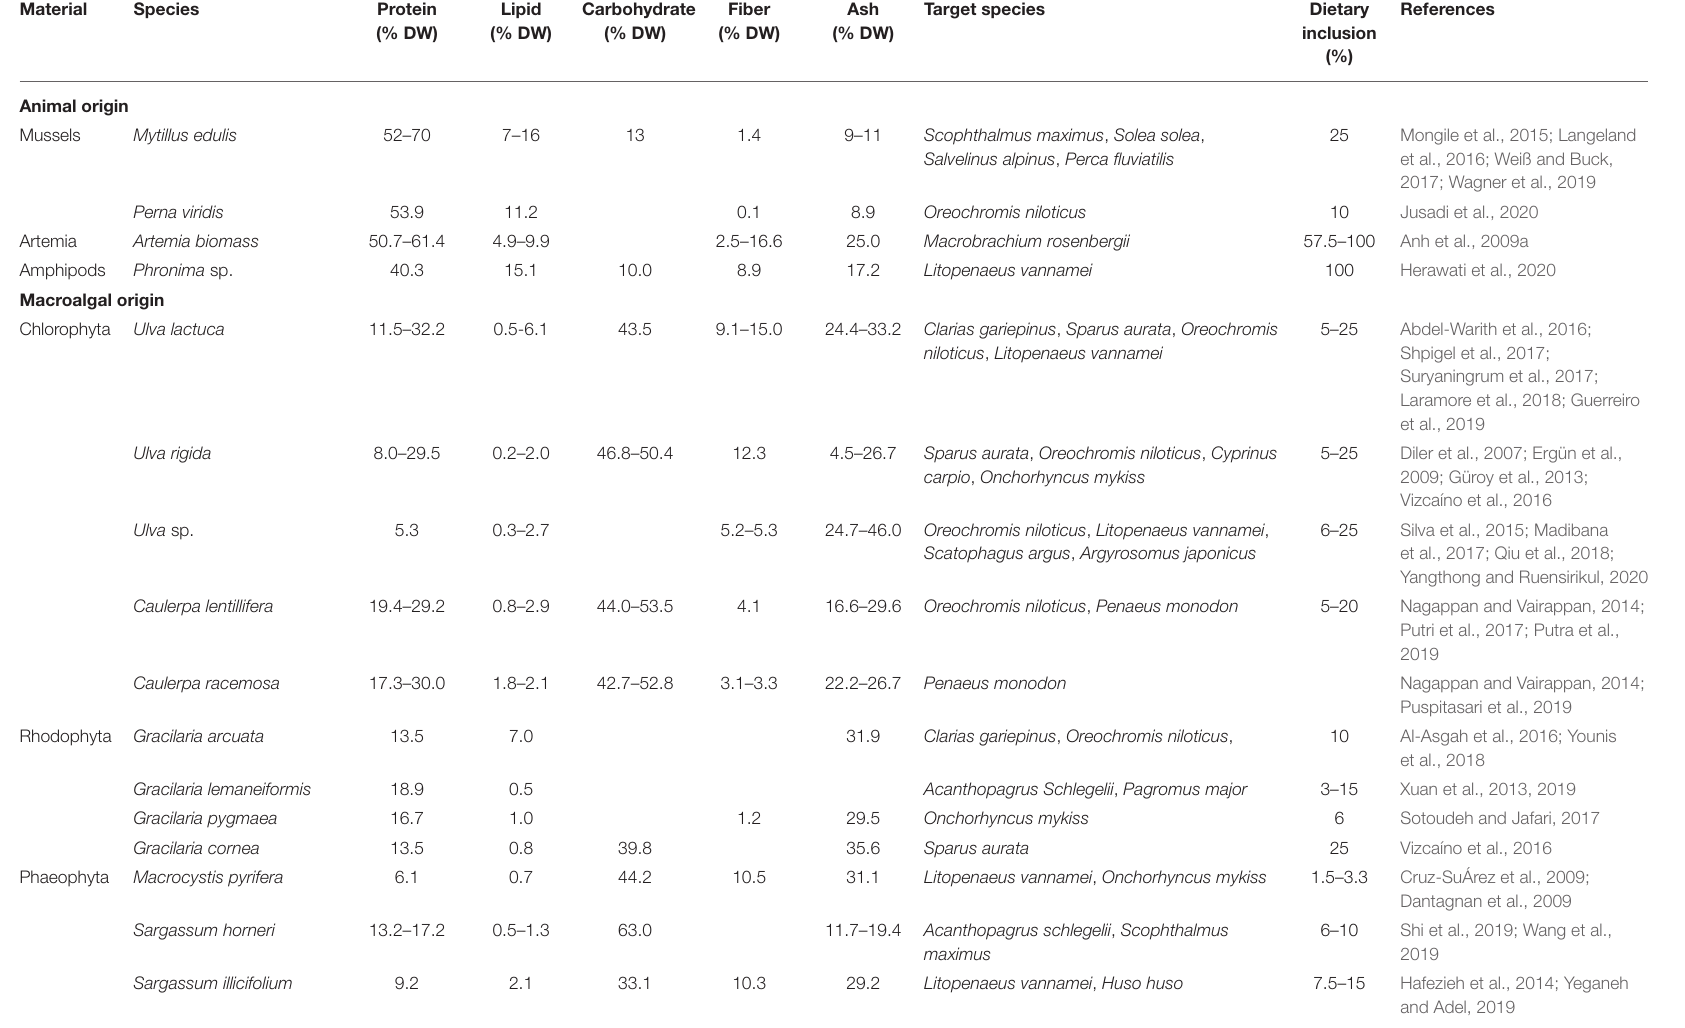
TABLE 1 | Nutritional compositions of some underutilized marine organisms and its utilization as feed raw materials in aquaculture. Material